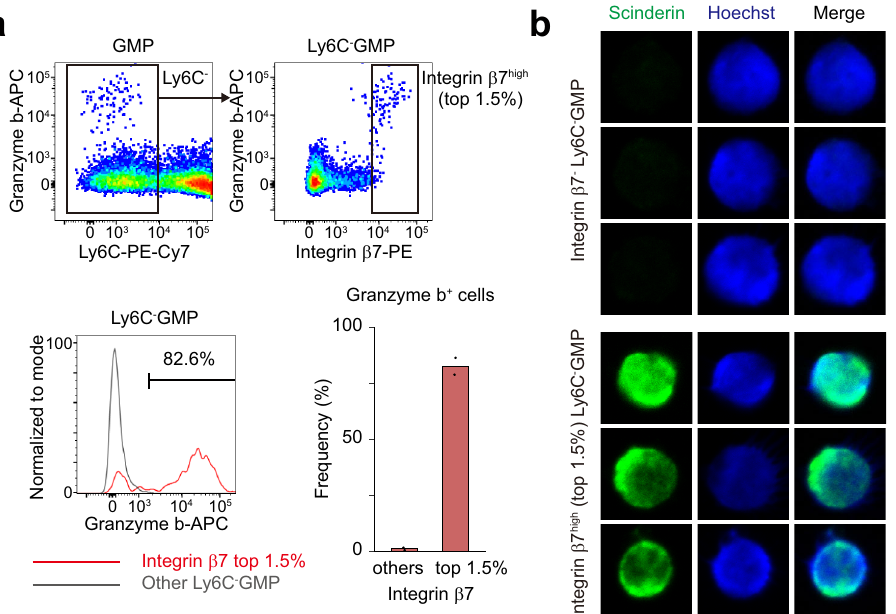
Fig. 9 | Ly6C - GMPs with very high expression of Integrin β 7 have intracellular Granzyme b and Scinderin. a Granzyme b expression in GMPs (left) and Ly6C - GMPs(right)analyzedbyFACS.FACSgatingstrategiesareshowninSupplementary Fig.14b.TheleftlowerhistogramcomparestheexpressionofGranzymebbetween Integrin β 7 high Ly6C - GMPs(red, thoseranked inthetop1.5%of allLy6C - GMPs)and other Ly6C - GMPs (grey). The percentages of Granzyme b + cells are also shown in